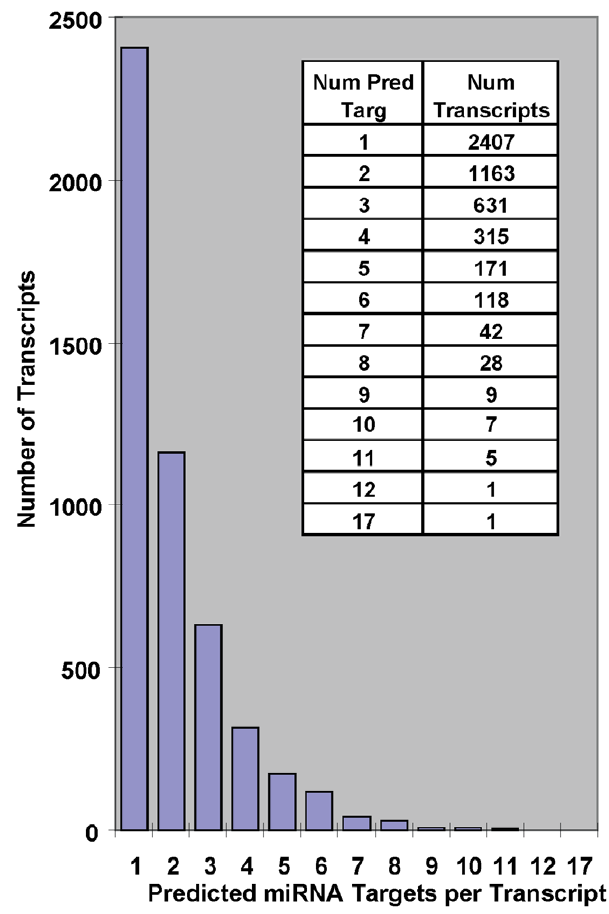
Figure 3. Distribution of predicted 63-set target sites in individual transcripts. The TargetScan algorithm was used for miRNA target prediction and there are hundreds of transcripts containing multiple predicted 63-set target sites. We increased the stringency for the predicted target sites of the 63 miRNAs by applying a context score filter above the 60th percentile. This reduced the number to 10,751 predicted target sites in 4899 rat genes.